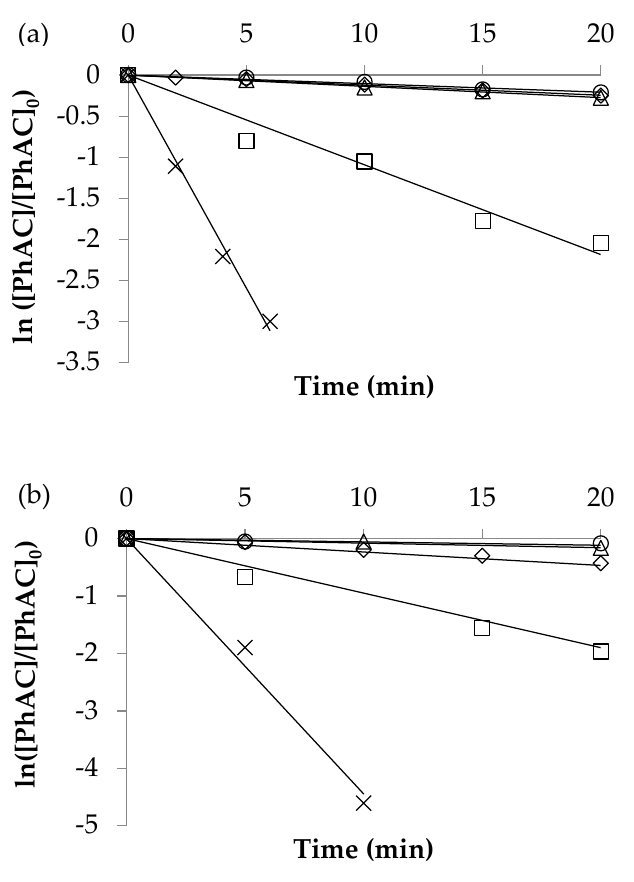
Figure 2. UVC photolysis of ACT, ATL, (cid:3) BZF, (cid:52) IBU, × DIC: ( a ) isolated, [PhAC] 0 = 5 mg L − 1 ; (cid:51) (cid:35) ( b ) mixed, [PhAC] 0 = 5 mg L − 1 .